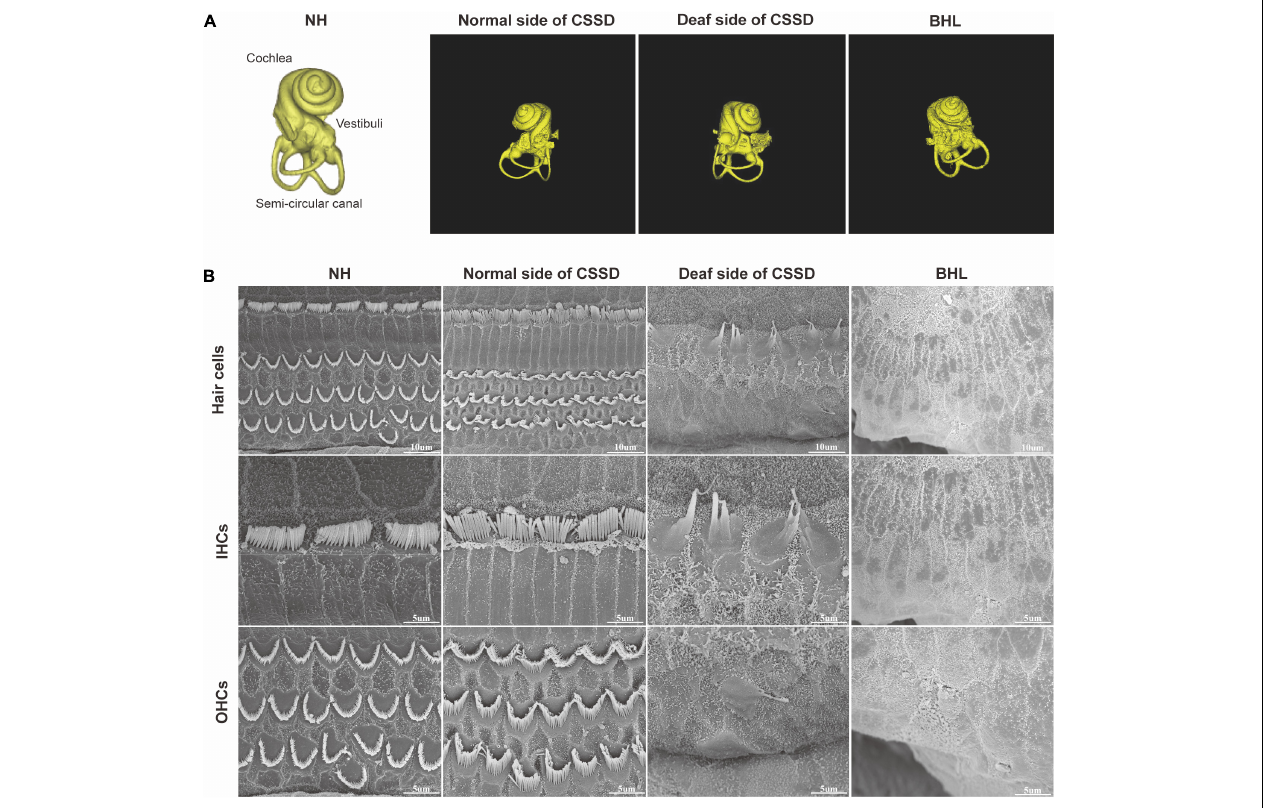
FIGURE 4 | The micro-CT images of different phenotypes and SEM images of inner ear basal membrane in congenital single-sided deafness (CSSD) pedigree. (A) Micro-CT 3D reconstructions of the cochlear of different phenotypes in the pedigree. (B) SEM images of the inner ear basal membrane. The normal side of a CSSD individual exhibited normal inner ear structure as the normal hearing (NH) ones. Sporadic inner hair cells (IHCs) with fused hair bundles were left in the deaf side of CSSD individuals. In bilateral hearing loss (BHL) individuals, nearly no hair cells were left on the basal membrane. The BHL showed more severe deterioration compared to the deaf side of